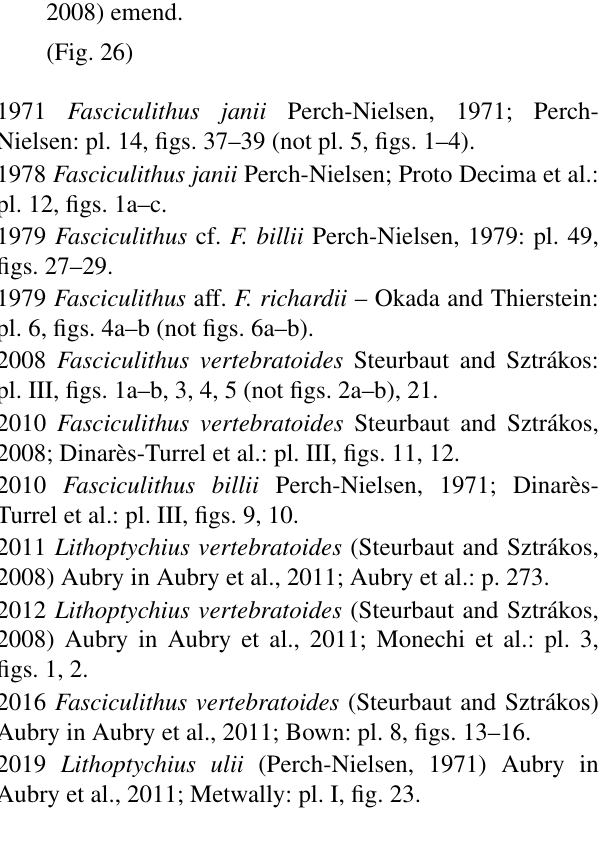
Nielsen (1971). However, F. vertebratoides differs from T. janii in the absence of a disk-shaped tectum that extends well beyond the column. Fasciculithus vertebratoides differs from F. billii in having a vertebra outline, a deep and wider distal depression, and a calyptra with vertical